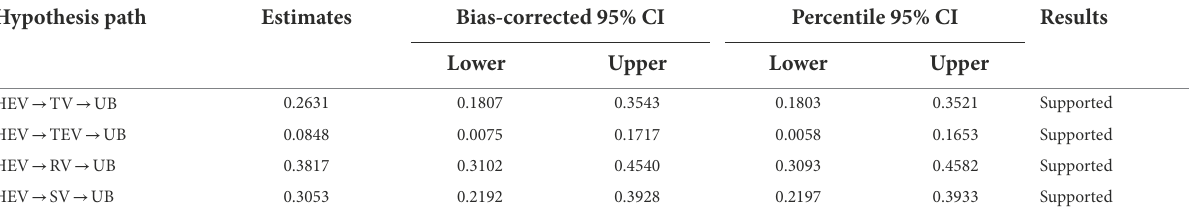
TABLE 4 Mediation effect